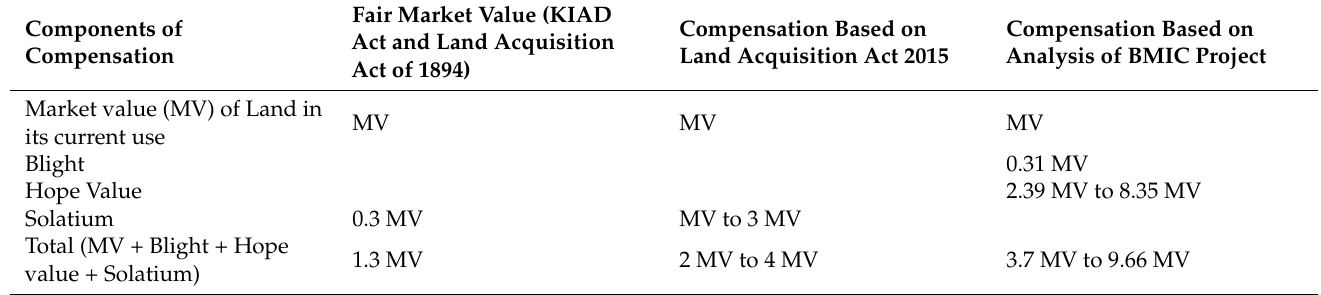
Table 6. Comparing compensation under the current acts and research